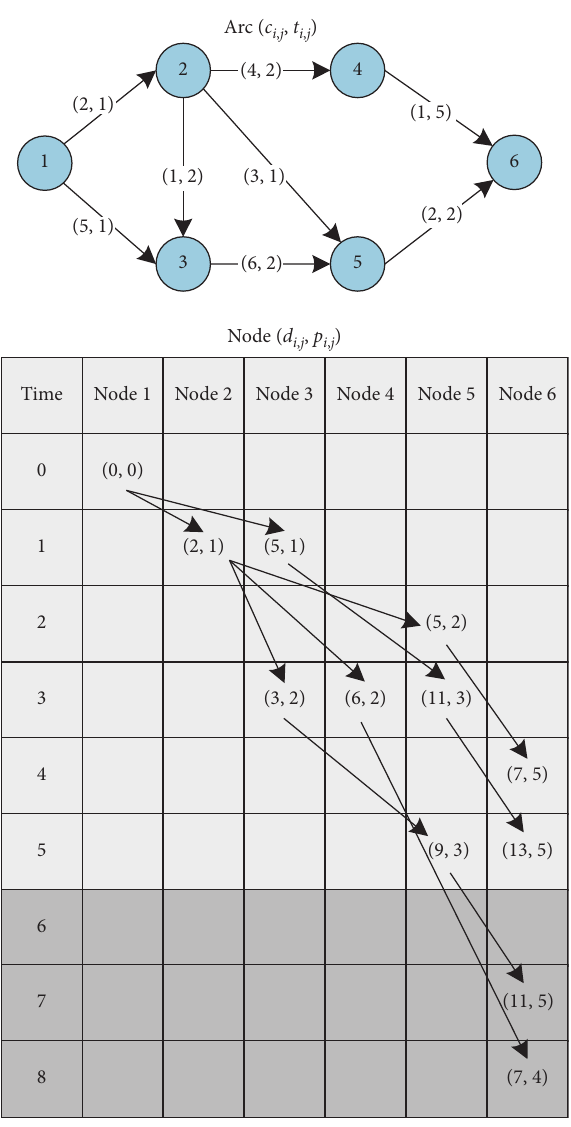
Figure 4: An illustrative example of the